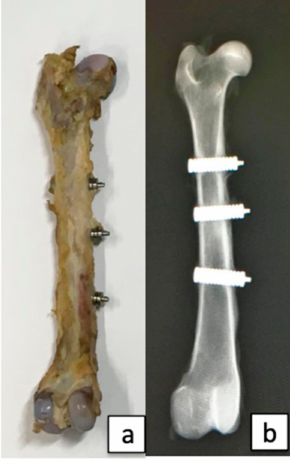
Figure 3. ( a ) Collected femur; ( b ) Radiograph of femoral bone.